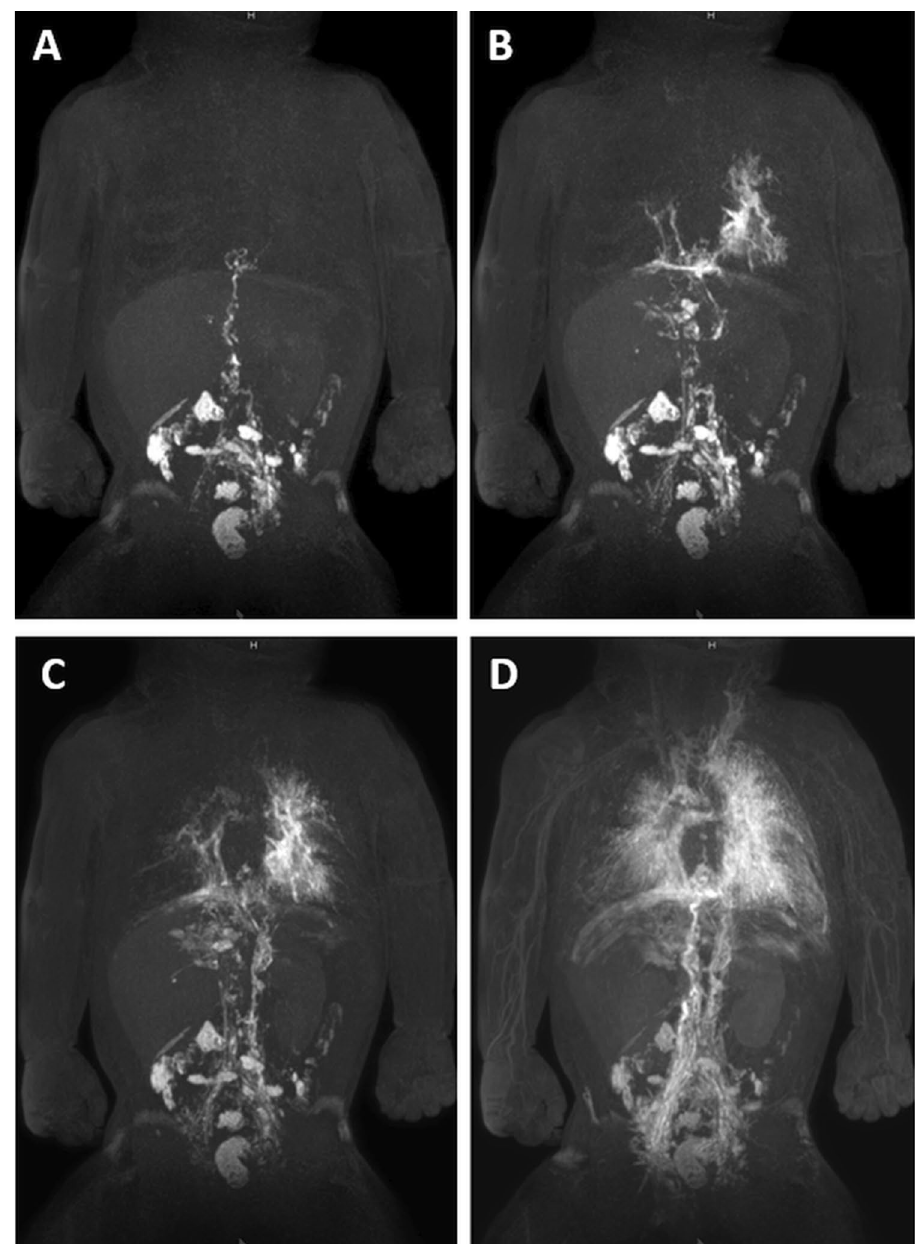
MR-lymphangiograms showing thoracic duct aplasia in the thorax with massive lymphatic reflux into both lungs. There is collateral flow through peribronchial, diaphragmatic and pleural / intercostal lymphatics and ultimately drainage towards the left venous junction with delayed enhancement of blood